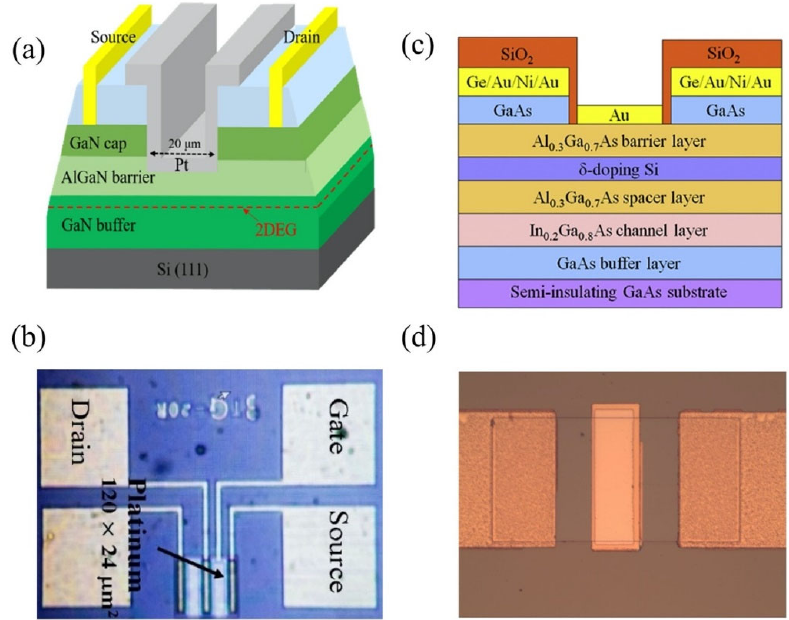
Figure 9. High electron mobility transistor devices. ( a ) A typical epitaxial structure of an Al- GaN/GaN HEMT sensor. ( b ) Top view image of an AlGaN/GaN HEMT sensor with floating gate. Reproduced with permission from [175]. Copyright 2021 MDPI. ( c ) AlGaAs/InGaAs HEMT structure. ( d ) Top view image of AlGaAs/InGaAs sensor proposed by Wang et.al. Reprinted from [182], Copyright 2015, with permission from Elsevier.